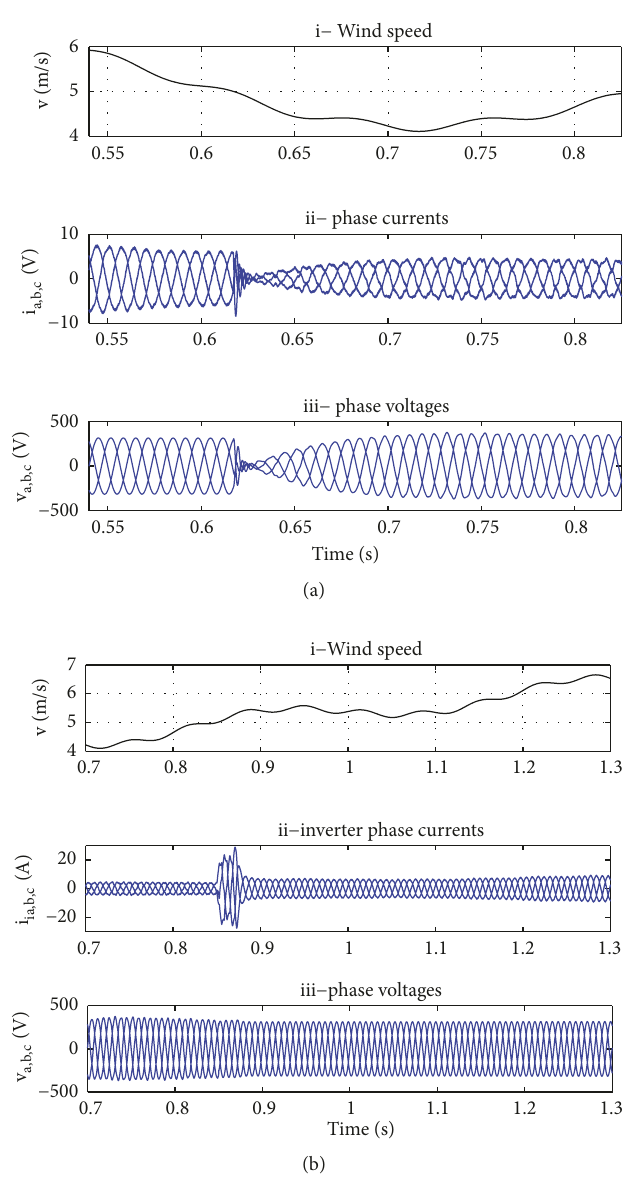
Figure 12: Performances of the proposed PI controllers in automatic switching mode. (a) Zoom on the transition from the grid connected mode to the stand-alone mode. (b) Zoom on the transition from the stand-alone mode to the grid connected